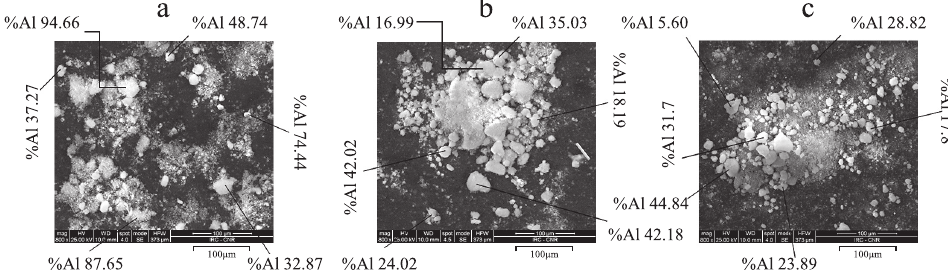
Fig. 8 SEM images and EDS analysis of nanoparticle aggregates. (a) Sample taken after 14 min during the A mixing test; (b) sample taken after 4 min during the B mixing test; and (c) sample taken after 1 min during the C mixing